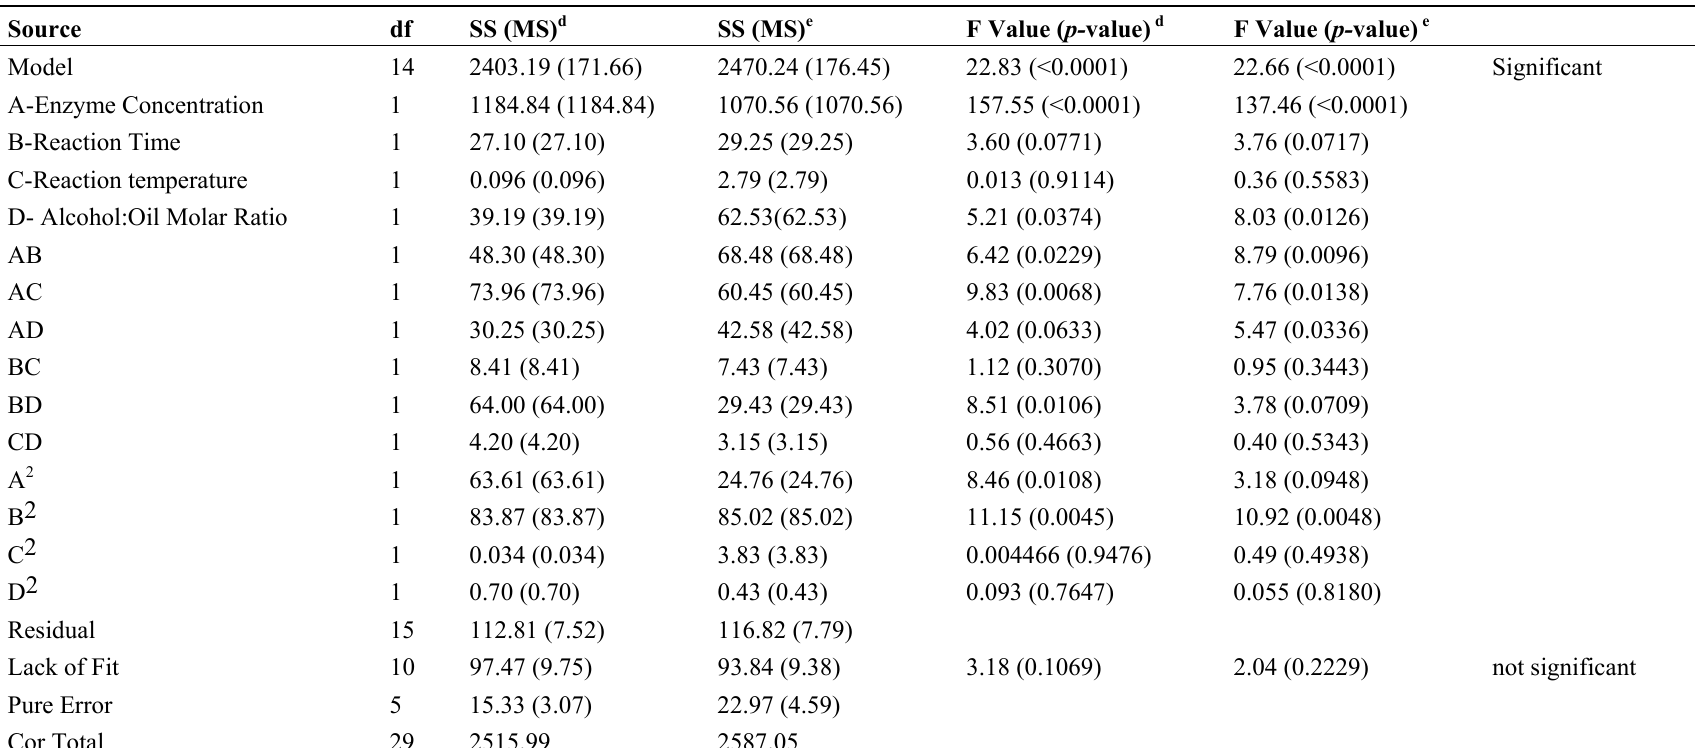
Table 6. Response surface quadratic model analysis of variance (ANOVA)table for enzymatic transesterification of sunflower